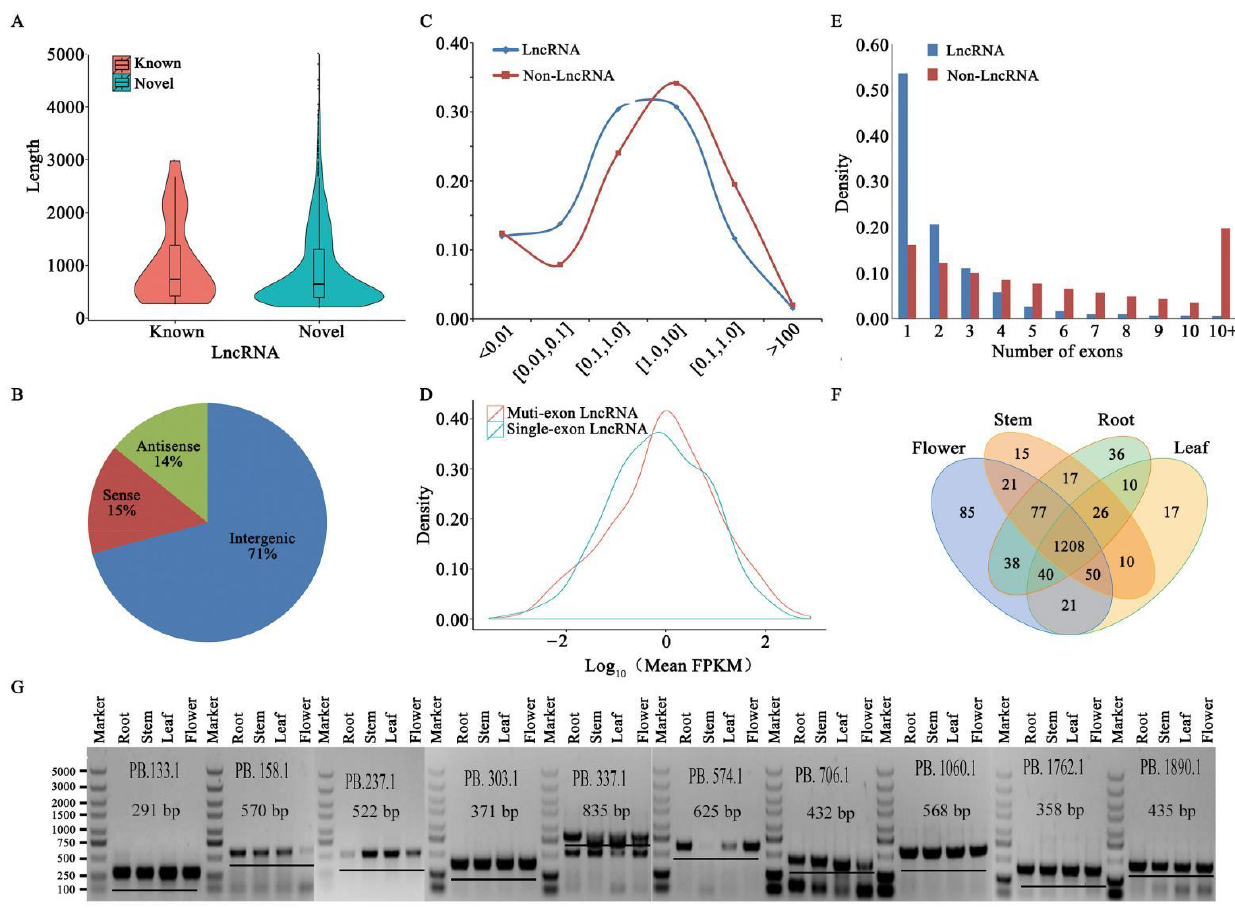
Figure 3. Characterization of identified lncRNAs. ( A ) Comparison of lengths of previously reported lncRNAs with novel lncRNAs identified in our study. ( B ) Proportions of three kinds of lncRNAs, classified according to their position relative to protein-coding genes. ( C ) Comparison of overall expression between lncRNAs and non-lncRNAs. ( D ) Comparison of overall expression between single-exon lncRNAs and multi-exon lncRNAs. ( E ) Number of exons in lncRNAs and non-lncRNAs. ( F ) Overlap of lncRNAs among the four tissue samples: root, stem, leaf, and flower. ( G ) Validation of 10 LncRNA transcripts using RT-PCR.